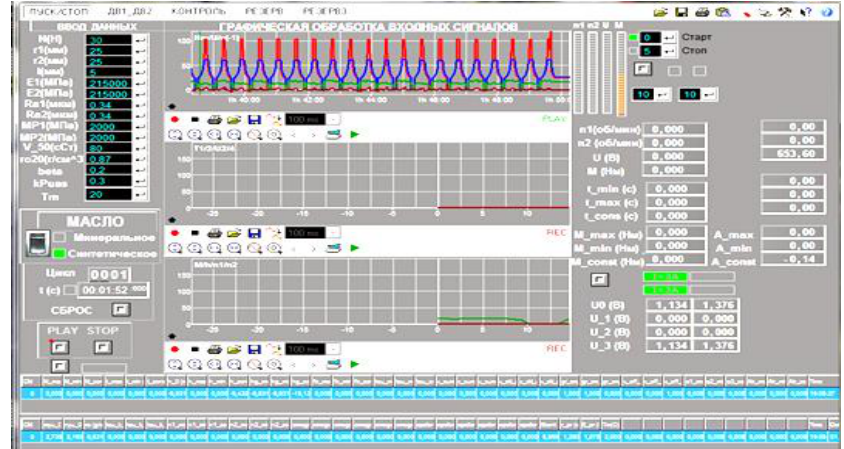
Fig. 2. Interface of subprogram for data processing during tribosystem operation in nonstationary friction conditions